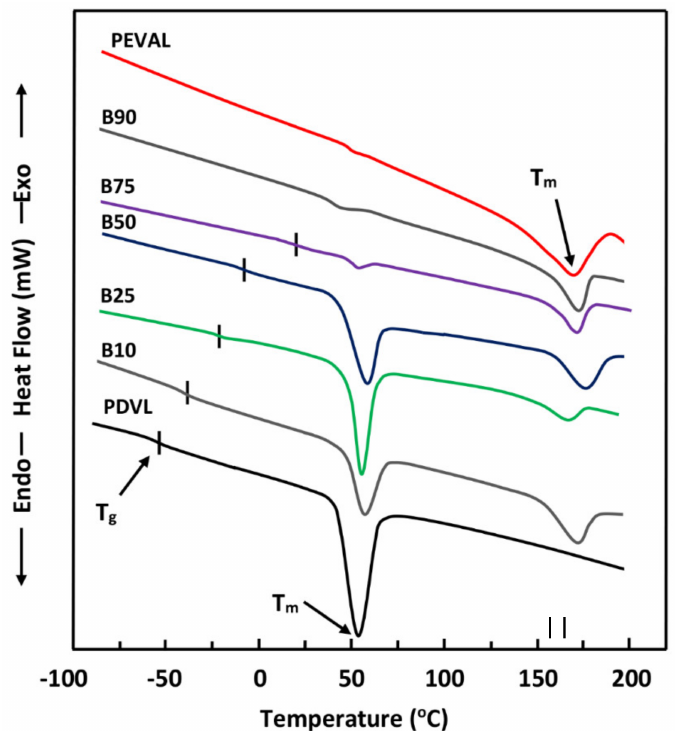
Figure 3. DSC thermograms of pure PE- co -VAL, pure P δ -VL, and PE- co -VAL/P δ -VL blends containing 90 wt% of PE- co -VAL (B90), 75 wt% of PE- co -VAL(B75), 50 wt% of PE- co -VA(B50), 25 wt% of PE- co -VAL (B25), and 10 wt% contents.